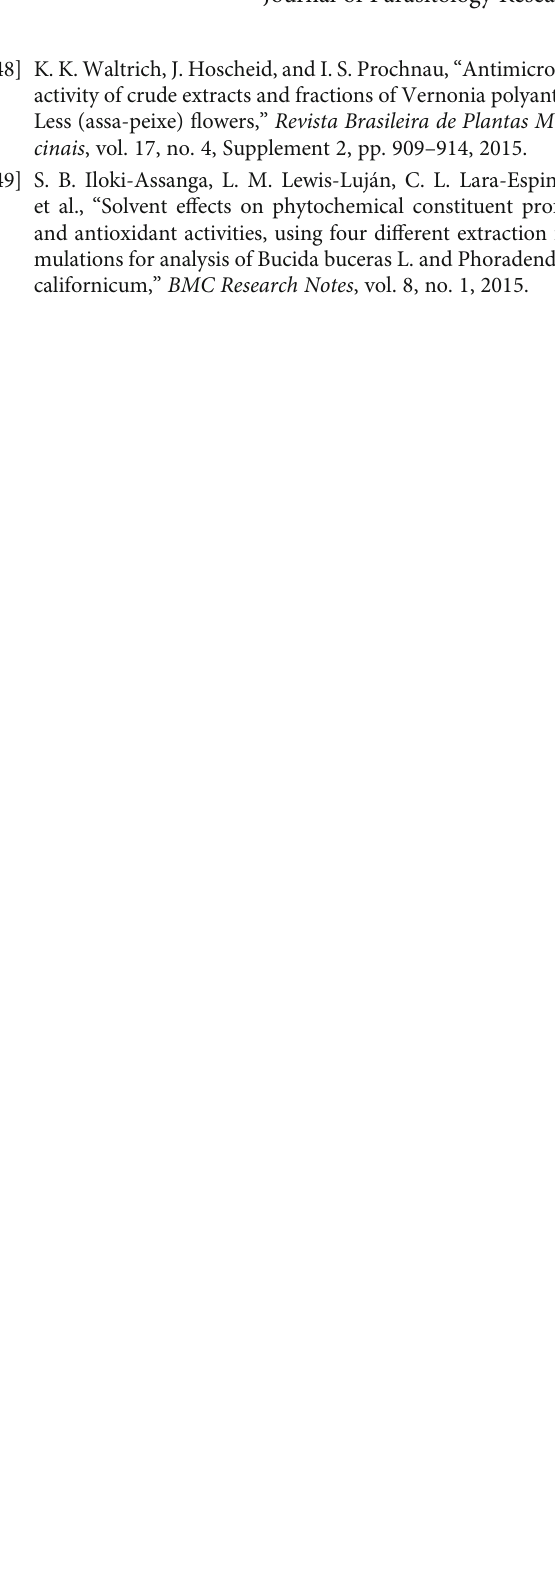
e ff ects of Newbouldia laevis and Zanthoxylum zanthoxyloïdes extracts on the exsheathment of third-stage infective larvae of gastrointestinal nematodes, ” Veterinary Parasitology